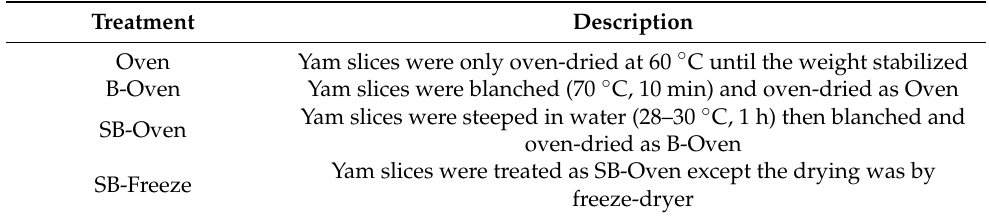
Table 1. Description of the post-slicing steps and conditions of each treatment group in the processing of yam